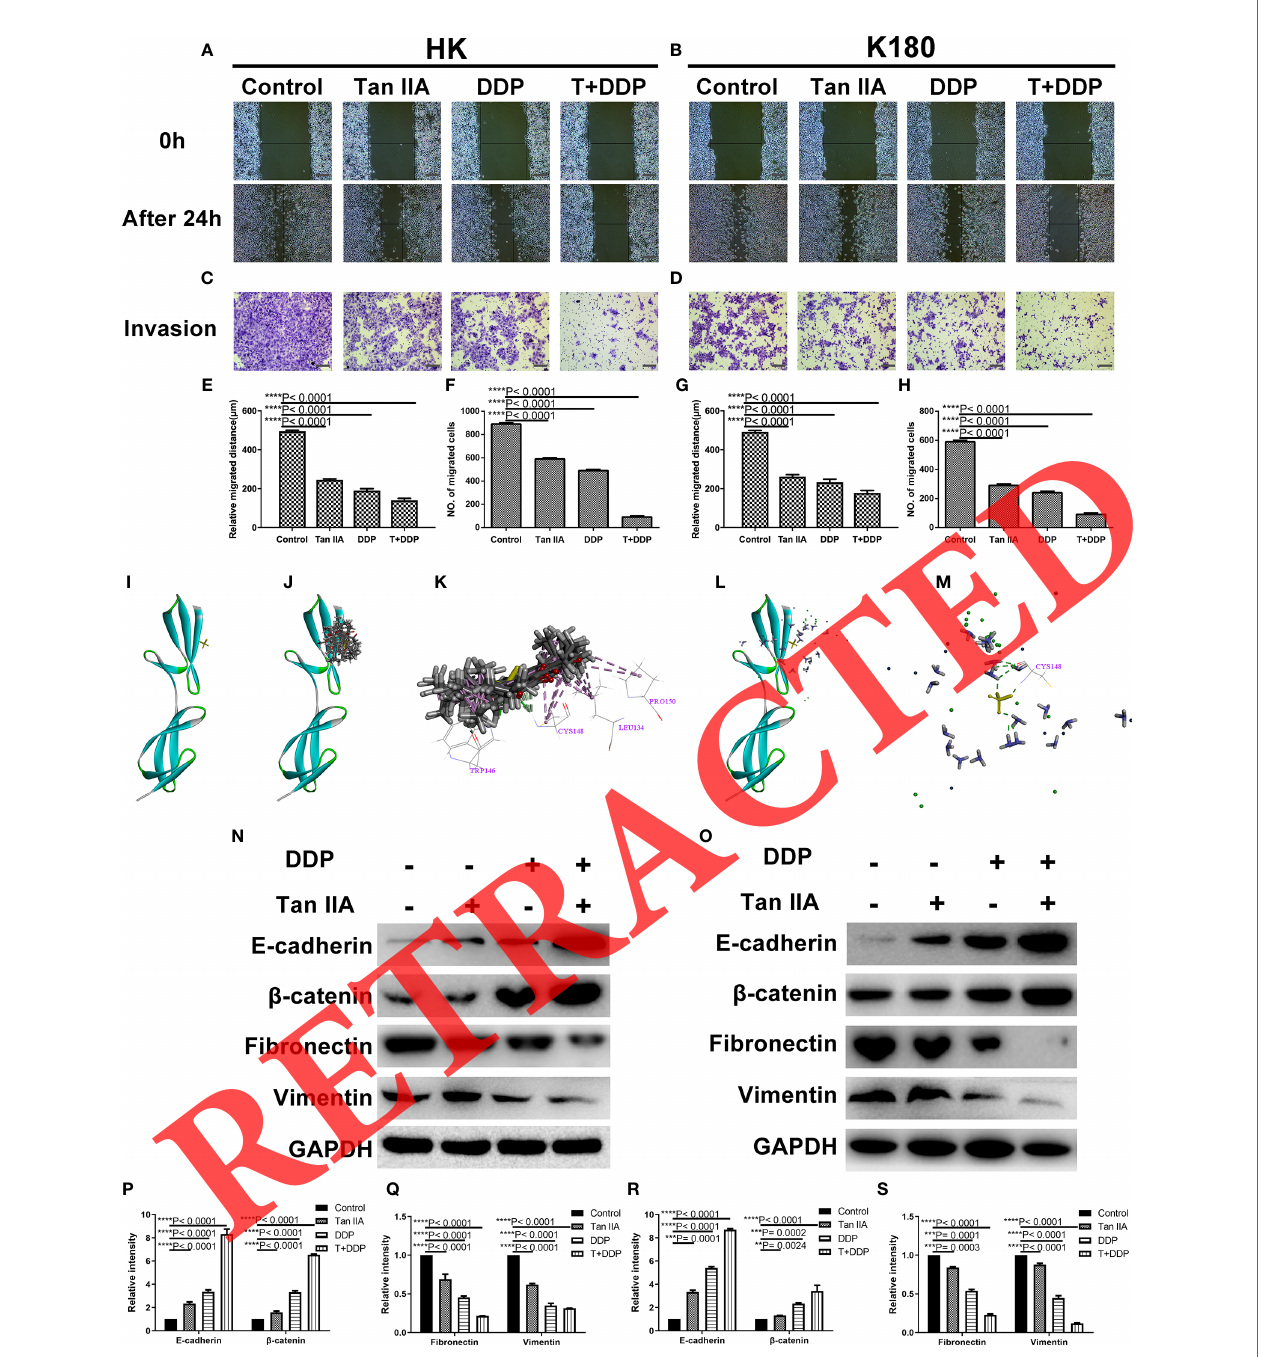
FIGURE 3 | Tan IIA and DDP suppressed migration and invasion ability of ESCC cells. Representative images of wound healing and transwell assay in HK (A, C) and K180 (B, D) cells following 24 h treatment with 6 µM Tan IIA, 3 µM DDP alone and 1 µM DDP and 2 µM Tan IIA in combination. Histograms depict the average migrated distance and the number of invasive cells in HK (E, F) and K180 (G, H) cells, respectively. The 3D crystal structure of human Fibronectin with an endogenous ligand (PDB-ID: 2cg6) (I) . Ten random poses of Tan IIA docked into the active site of 2cg6 (J) . The binding modes of Tan IIA in Fibronectin: at least fi ve residue involved in the interactions in ten random poses, TRP 146, CYS 148 (H-bonds) and LEU 134, CYS 148, PRO 150 ( p - p interaction) (K) . Ten random poses of DDP docked into the same active site of 2cg6 (L) . The binding modes of DDP in Fibronectin: at least one residue involved in the interactions in ten random poses, CYS 148 (H-bonds) (M) . Protein expression levels of E-cadherin, b-catenin, Fibronectin, Vimentin and GAPDH of HK and K180 cells following a 48 h treatment with 6 µM Tan IIA, 3 µM DDP alone and 1 µM DDP and 2 µM Tan IIA in combination (N, O) . Histograms depict the relative gray value of the related proteins measured using Image J (P – S) . All data are shown as the mean SD of three independent experiments. ** P < 0.01, *** P < 0.001, or **** P < 0.0001 versus the control group (magni fi cation, 100, Scale bars, 100